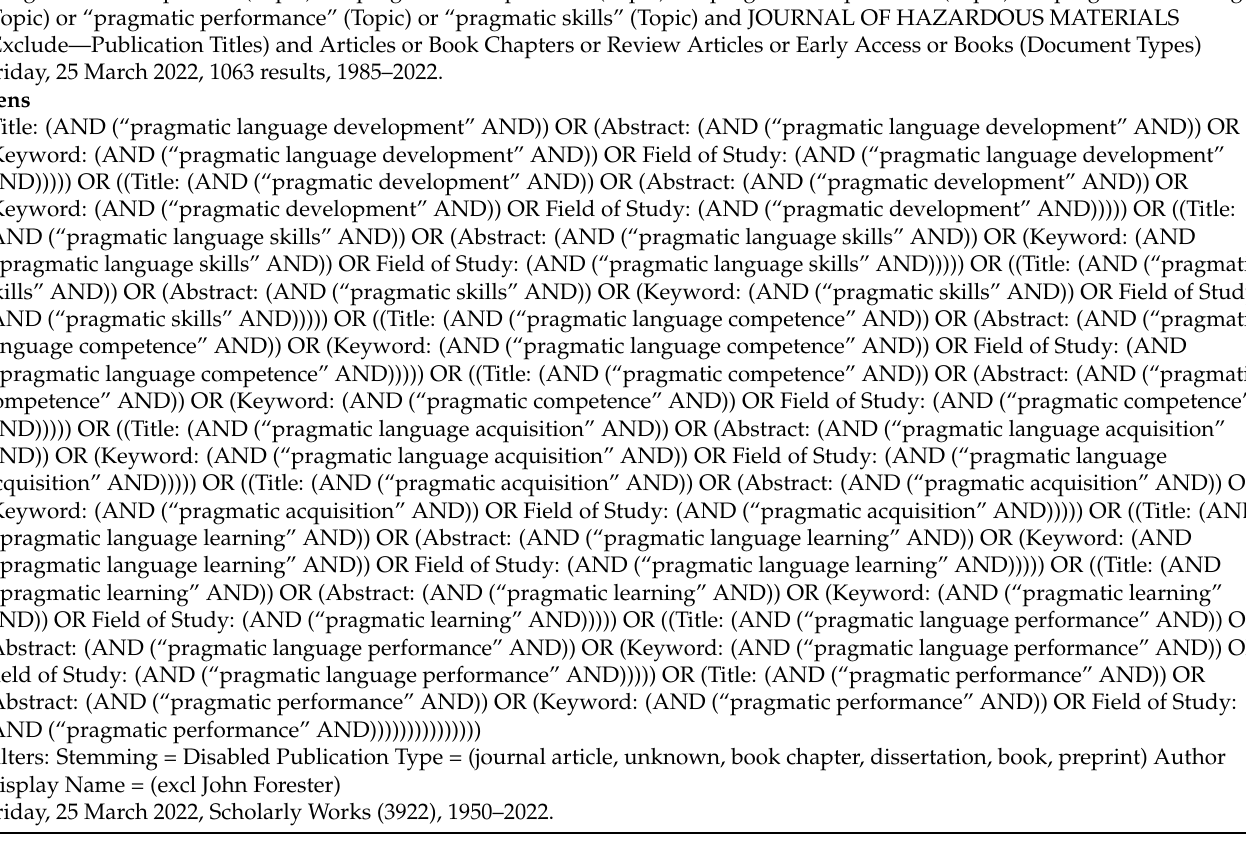
Table 4. Search strings for retrieving data on pragmatic language